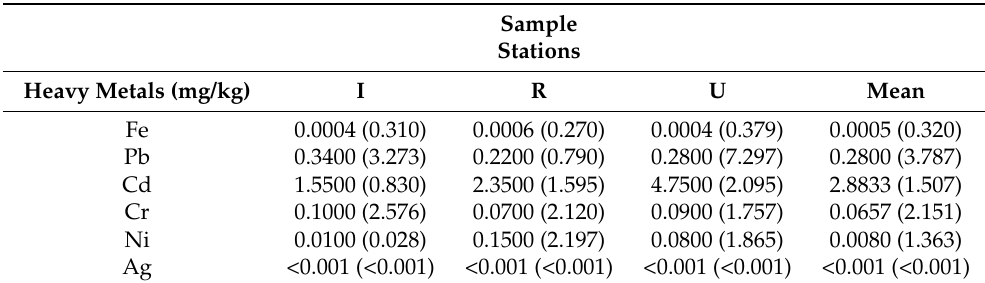
Table 3. Contamination factor ( CF ) for heavy metals in soils and Vernonia amygdalina Delile of campuses (I, R,